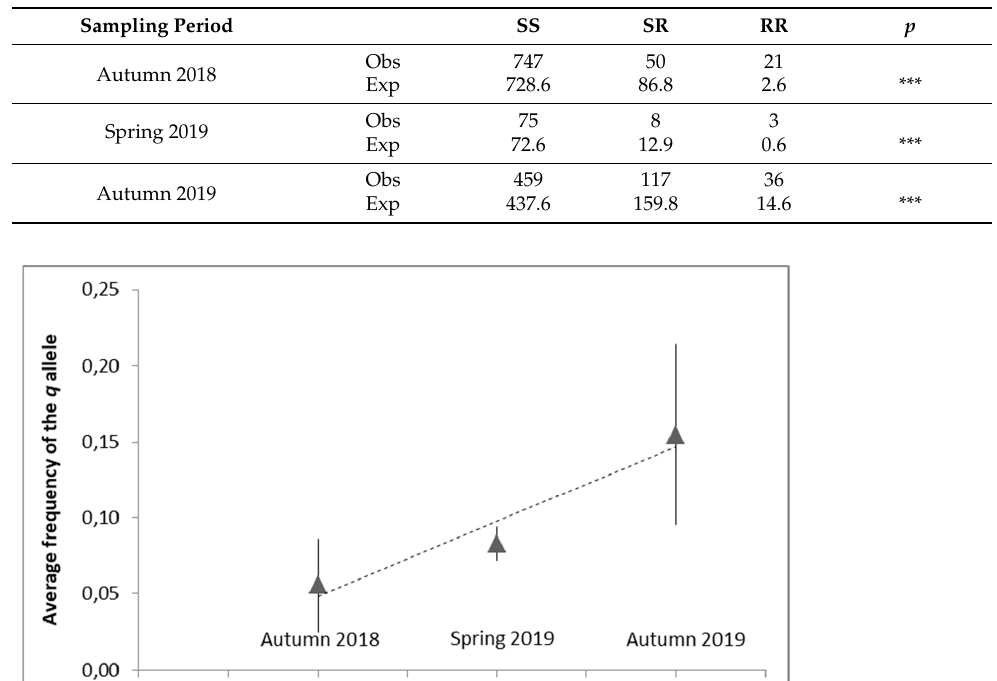
Table 2. Genotype frequencies observed (Obs) vs. expected (Exp) under Hardy–Weinberg equilib- rium. Pooled data across samplings. SS: homozygotes for the sensitive allele, SR: heterozygotes, and RR: homozygotes for the resistance allele; Obs: observed number of mites; Exp: expected number of mites under Hardy–Weinberg equilibrium; p , departure of the observed genotype frequencies from those expected under Hardy–Weinberg equilibrium; ***, p < 0.001, as estimated by means of a